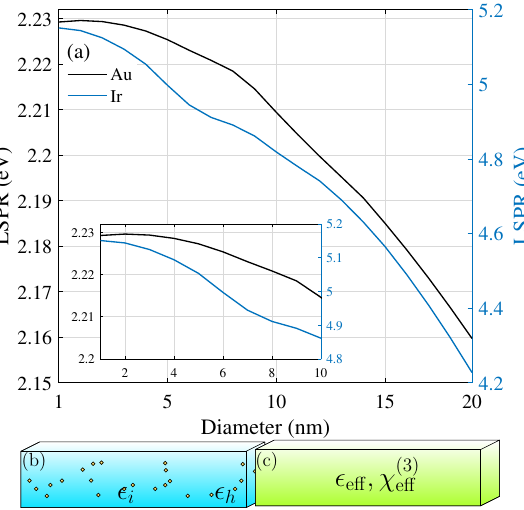
Figure 1. ( a ) Size dependence of the spectral position of the localized surface plasmon resonance (LSPR) of Ir and Au nanoparticles. ( b ) Illustration of the setup: Nanoparticles with permittivity (cid:101) i are embedded in the nonlinear host material Al 2 O 3 of permittivity (cid:101) h . ( c ) The system is treated within the nonlinear Maxwell–Garnett and Bruggeman theories to arrive at a homogeneous layer with effective ( 3 ) permittivity (cid:101) eff and effective third-order susceptibility χ eff